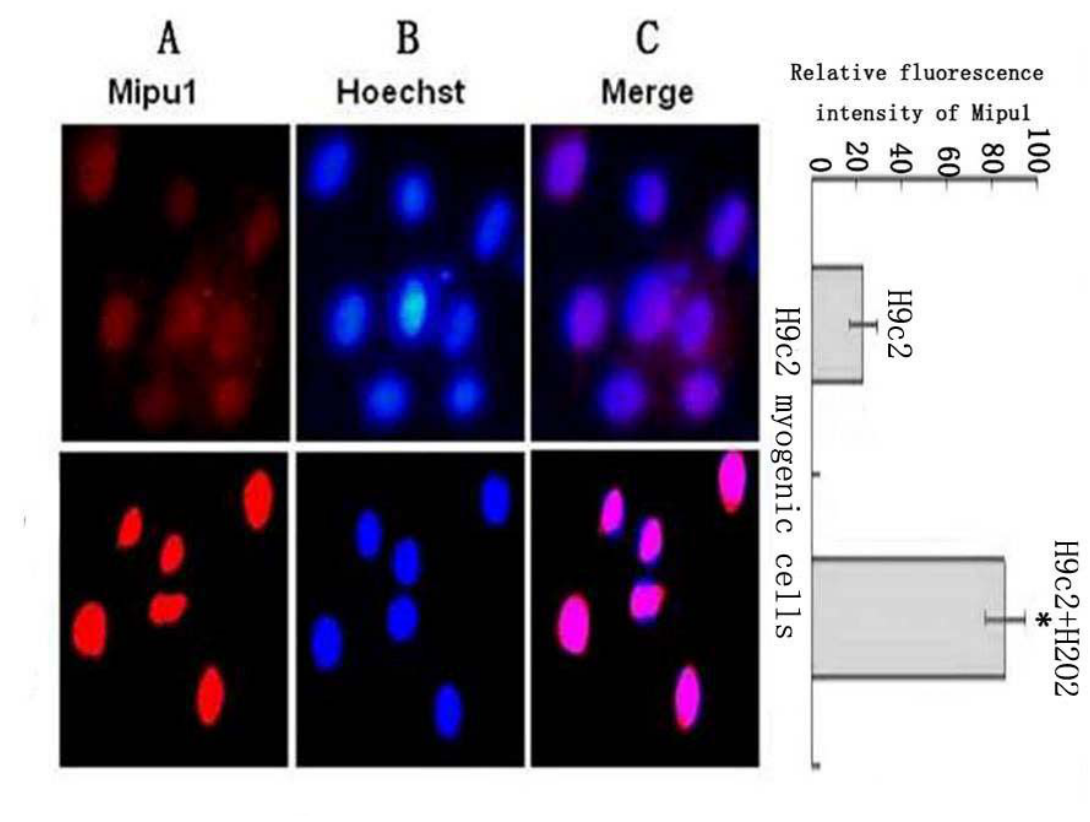
Figure 6. Sub-cellular localization analysis of the Mipu1 protein in H9c2 myogenic cells and the expression after the cells being treated with H intensity in the nuclear regions of multiple representative cells was determined using the Image ProPlus software and expressed as mean SEM (in arbitrary units) of six independent experiments. (A) Endogenous Mipu1 protein in H9c2 myogenic cells stained first with the anti-Mipu1 polyclonal antibody and then with CY3-conjugated goat anti-rabbit IgG (red). (B) The nuclei marked with Hoechst 33258 (blue). (C) Merged image of A and B (pink). * vs H9c2, P <